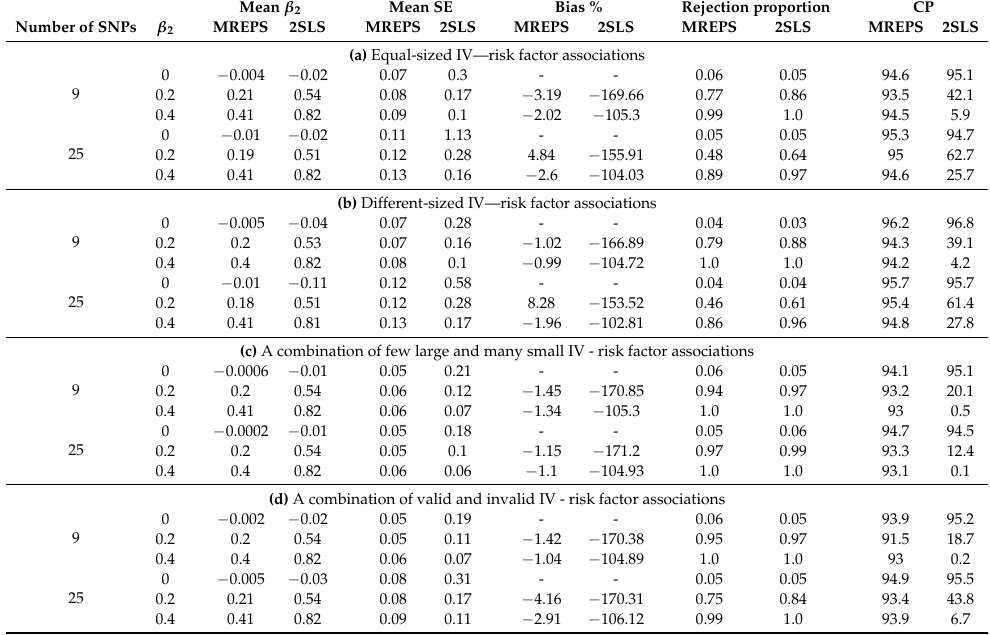
Table 1. Average estimators, average standard errors, bias percentages, rejection proportions, and cov- erage percentages obtained through MREPS and 2SLS under EPS Y